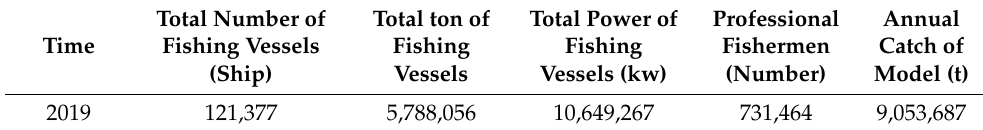
Table 7. Prediction of characteristic Polynomial